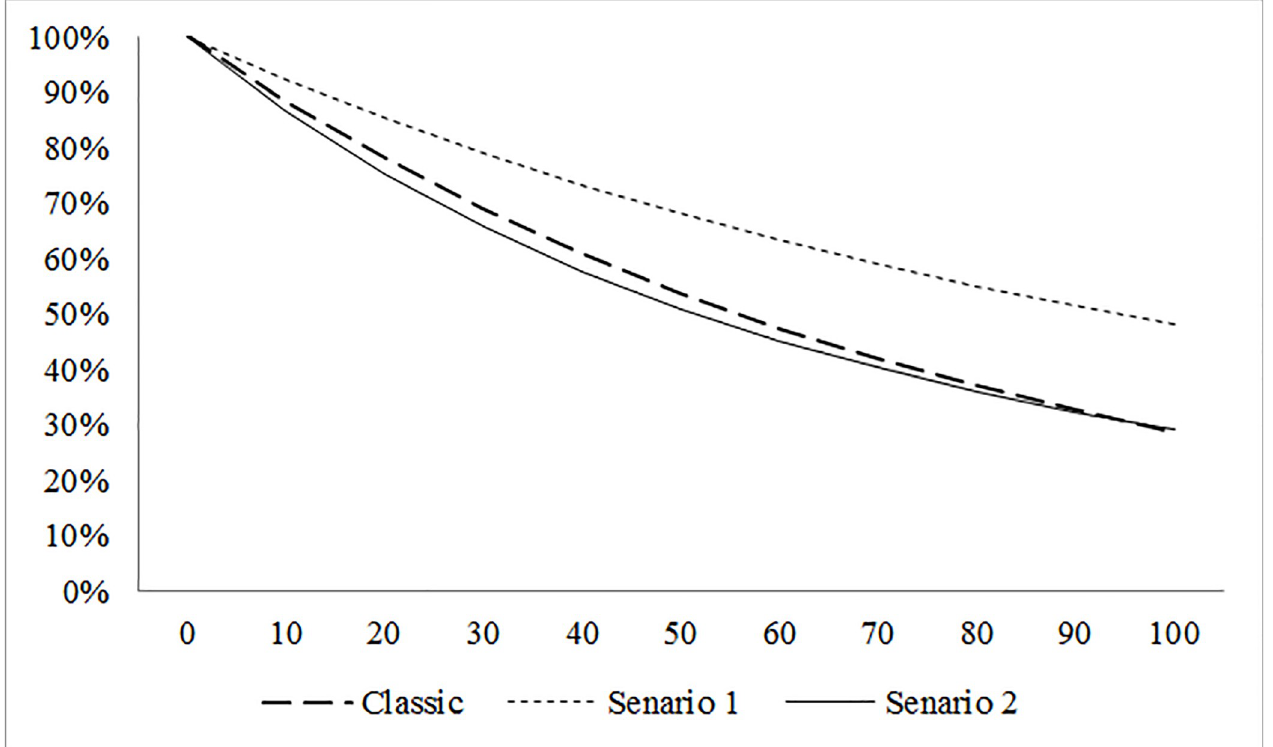
Fig 3. Reliability diagram of the classical and frailty exponential function for